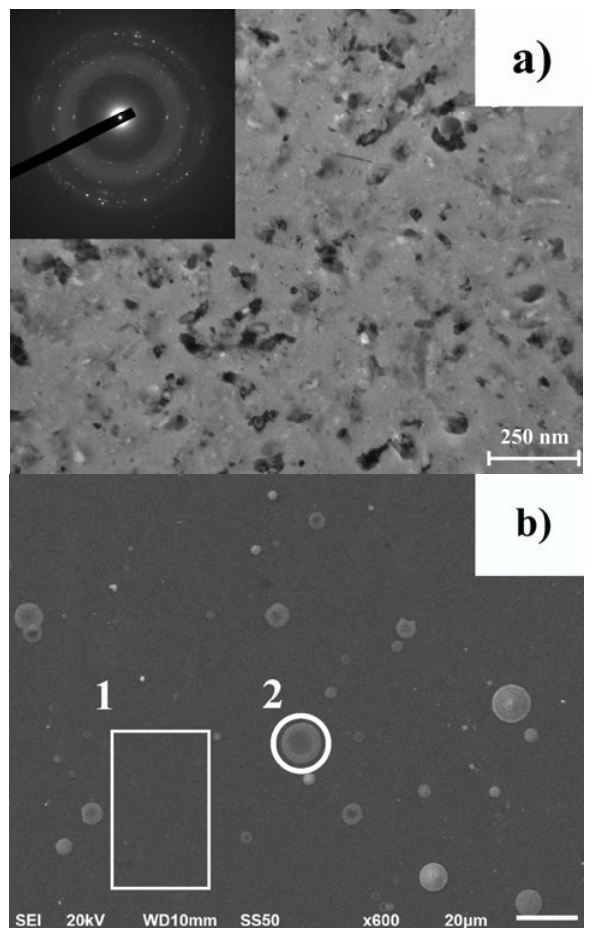
Fig. 1. Typical STEM (a) and SEM (b) images of InSb - MnSb films. The inset a) shows a ring structure of an